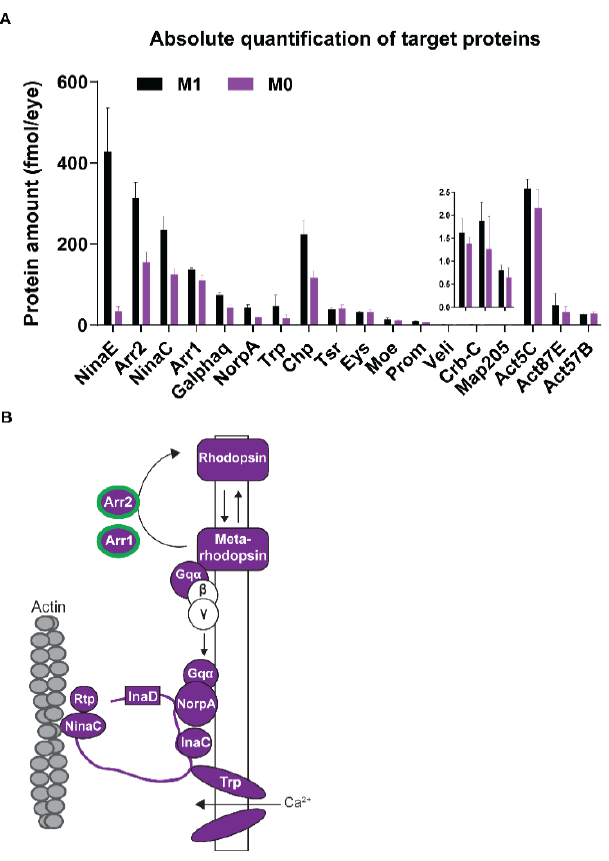
Figure 5. Quantification of major photoreceptor proteins of wild type Drosophila melanogaster raised on synthetic M1 diet or synthetic M0 diet (lacks vitamin A precursors). ( A ) Targeted absolute quantification of the molar amounts of proteins that play a major role in phototransduction or photoreceptor morphology for M1 diet (black) and M0 diet (purple), N=3 for each condition. Note the reduced levels of most phototransduction proteins and the structural protein Chp in vitamin A-deficient eyes (purple). Error bar indicates mean ± SD. ( B ) Vitamin A deficiency significantly decreases the abundances of phototransduction proteins. Note that almost all components are significantly decreased (purple color); Arr1 and Arr2 are regulated on the transcriptional level (green outline).